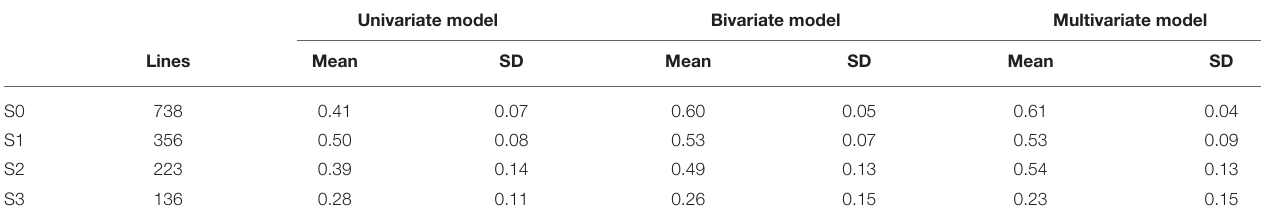
TABLE 3 | The mean and standard deviation (sd) of PA for grain yield within each breeding stage in the cross-validation method with the univariate, bivariate, and multivariate